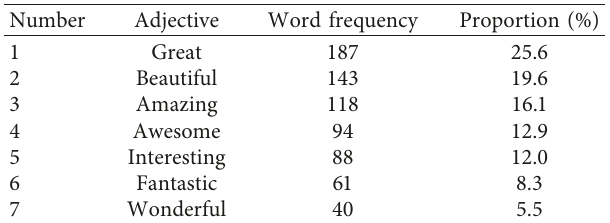
Figure 8: High-frequency words of cognitive image of inbound tourists in East Table 5: Emotional high-frequency words of inbound tourists obtained through UGC picture analysis.